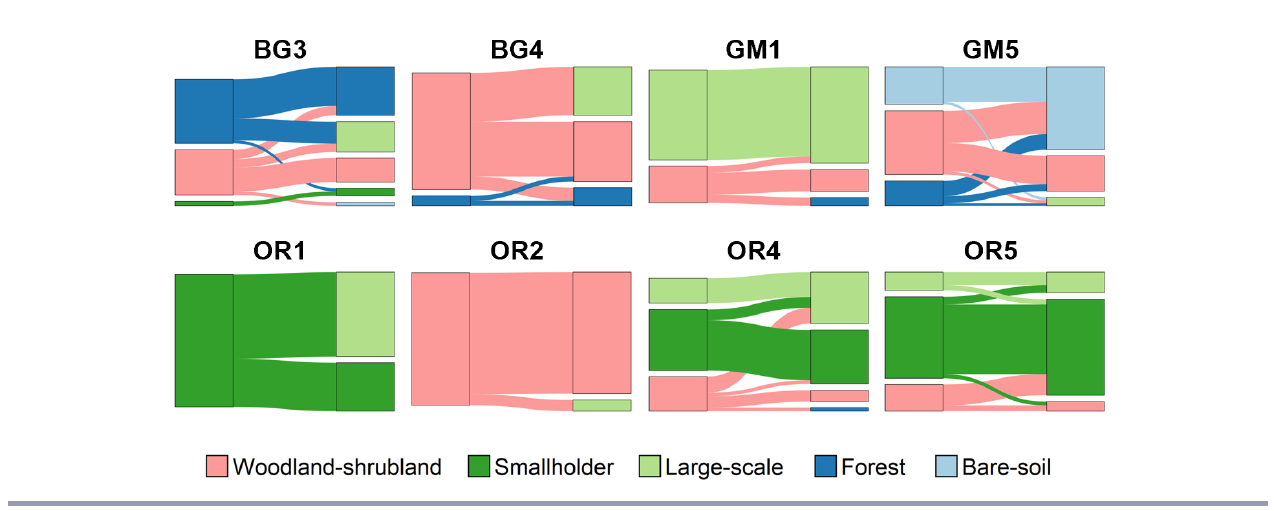
Fig. 4 . Direct land use and land cover changes within each site. For clarity, transitions smaller than 5% of the largest transition within each site are not displayed.